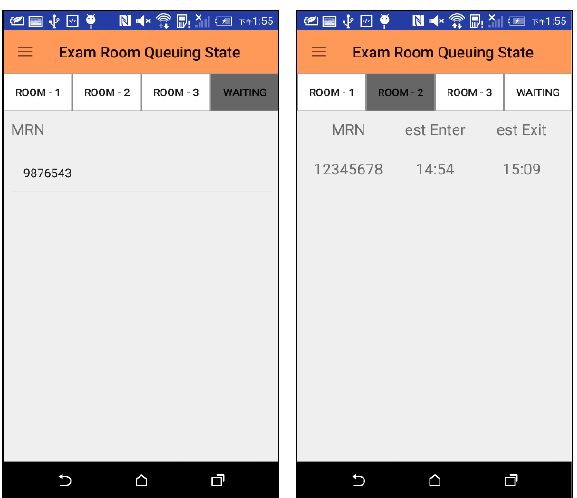
Figure 14. Waiting list for scan rooms and patient queues for each scan